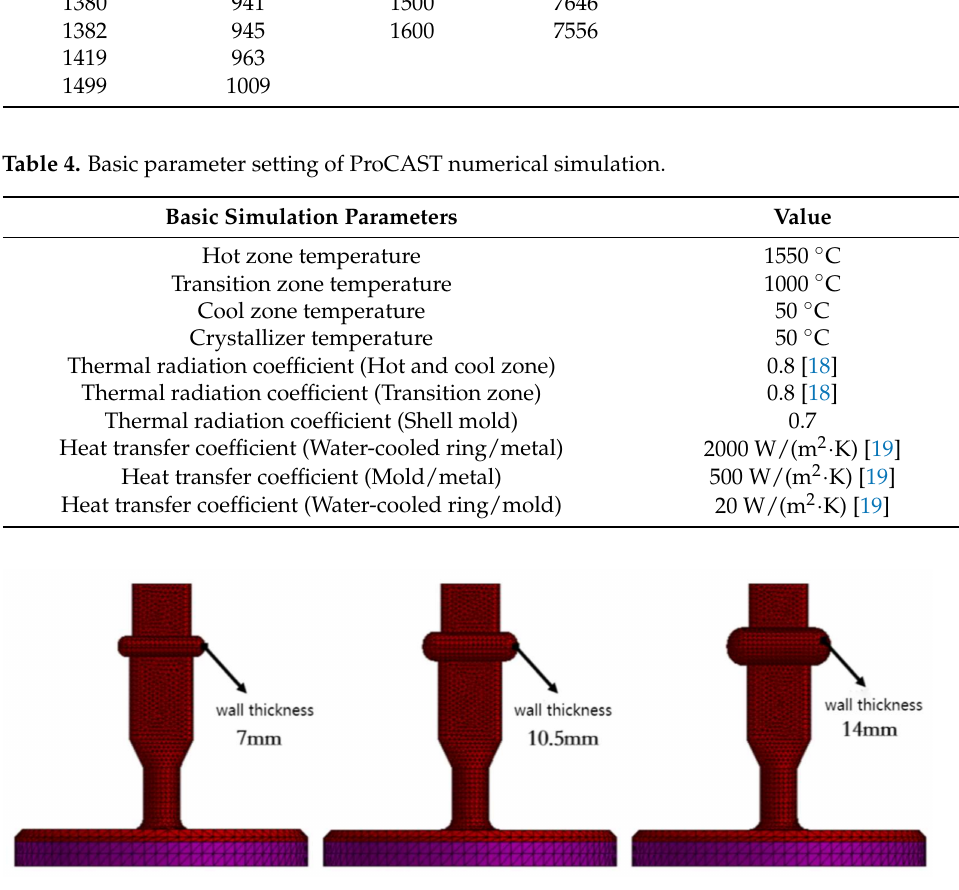
Figure 5. Mesh model of different wall thickness at the